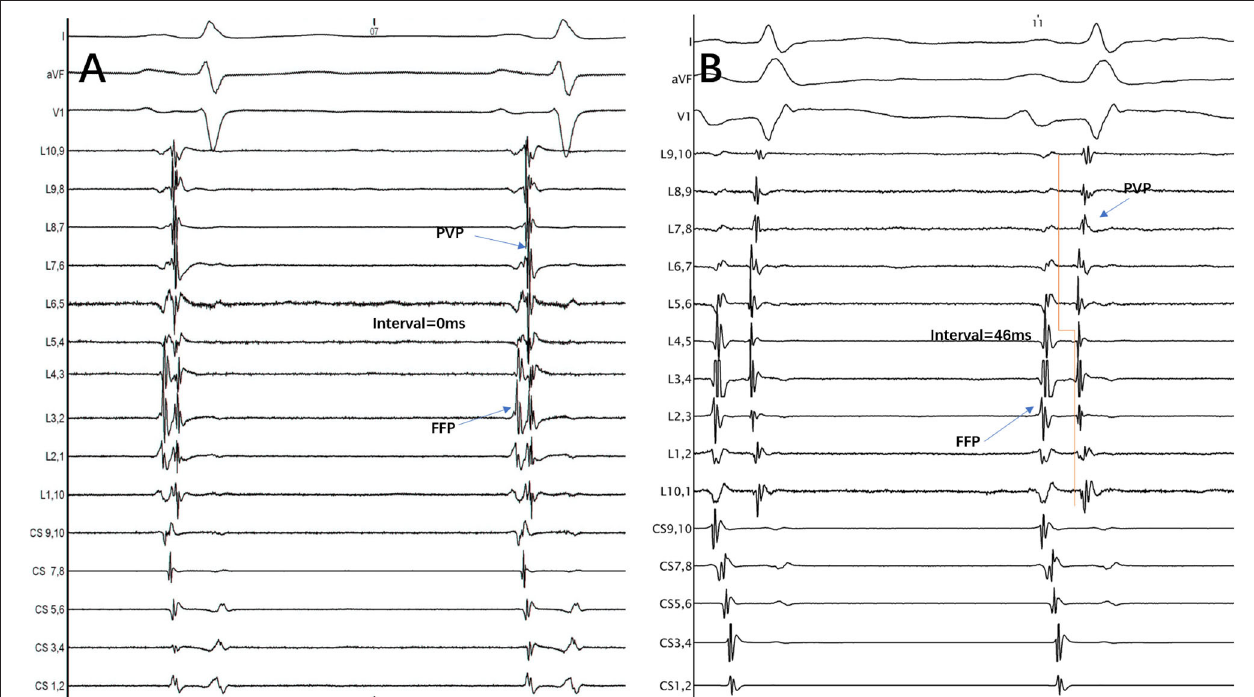
Development cohort Prospective cohort All Upper Lower Univariable Multivariable HR (95% CI) All Upper P -value P -value portion Portion